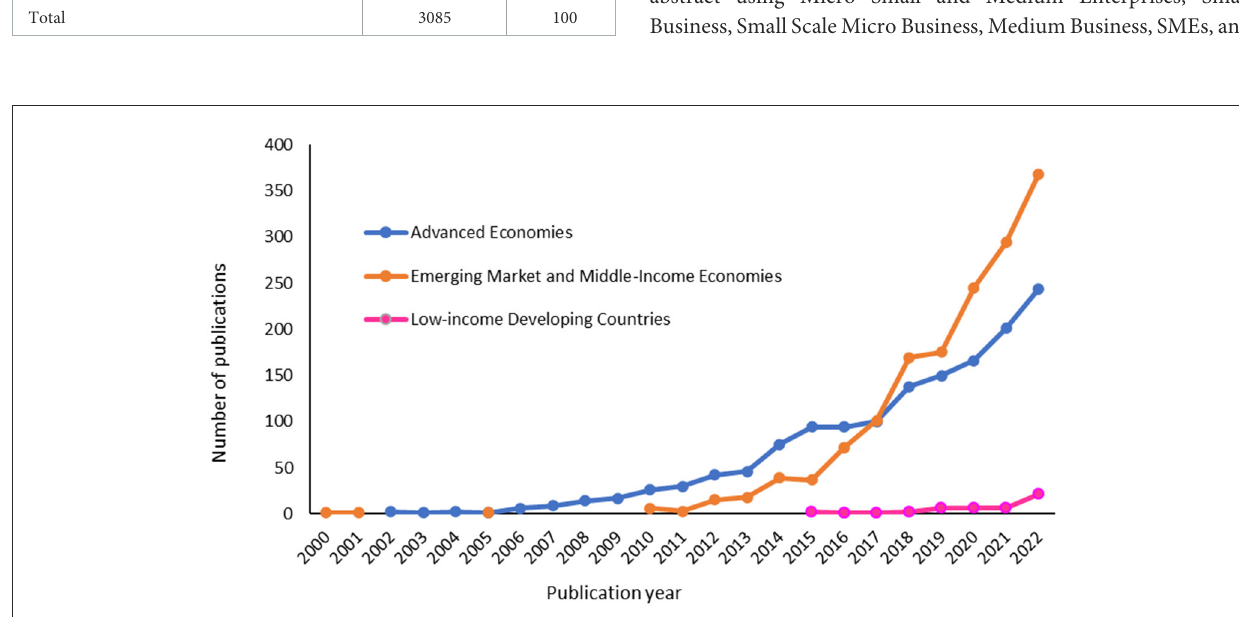
FIGURE9 Yearly contribution to SSCM per IMF country